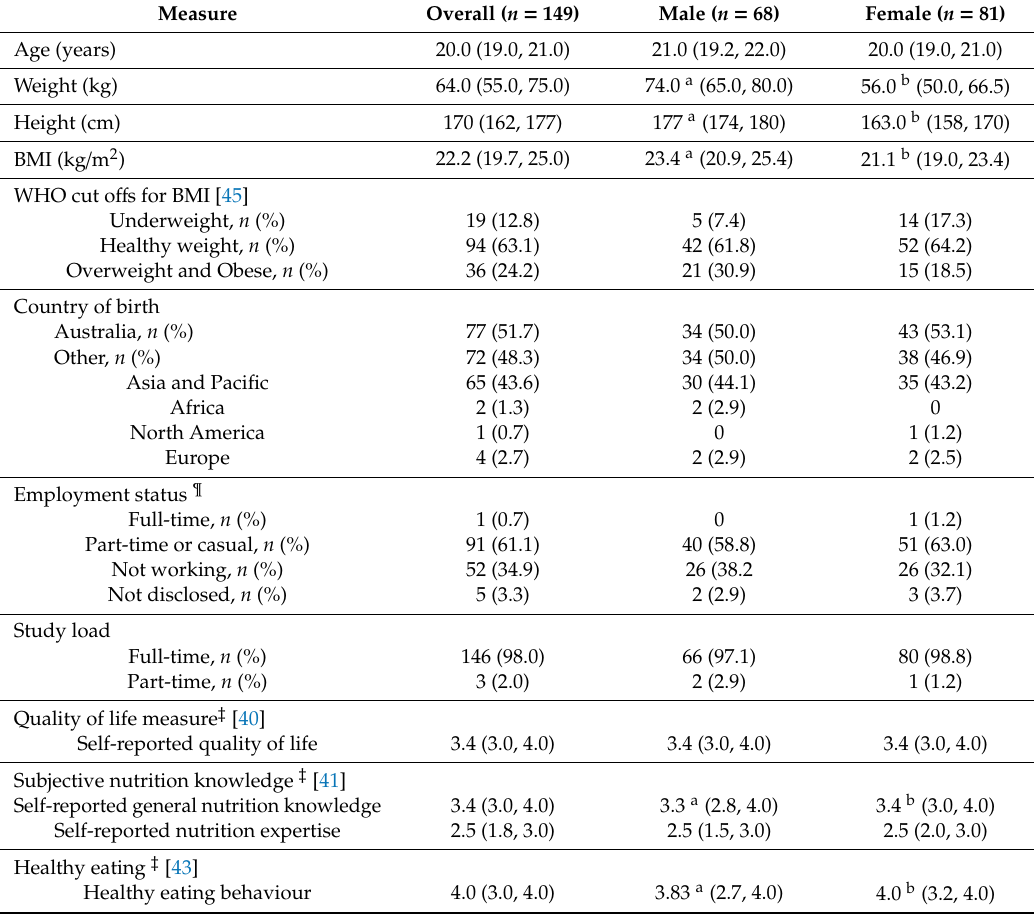
Table 1. Demographic characteristics of the study population